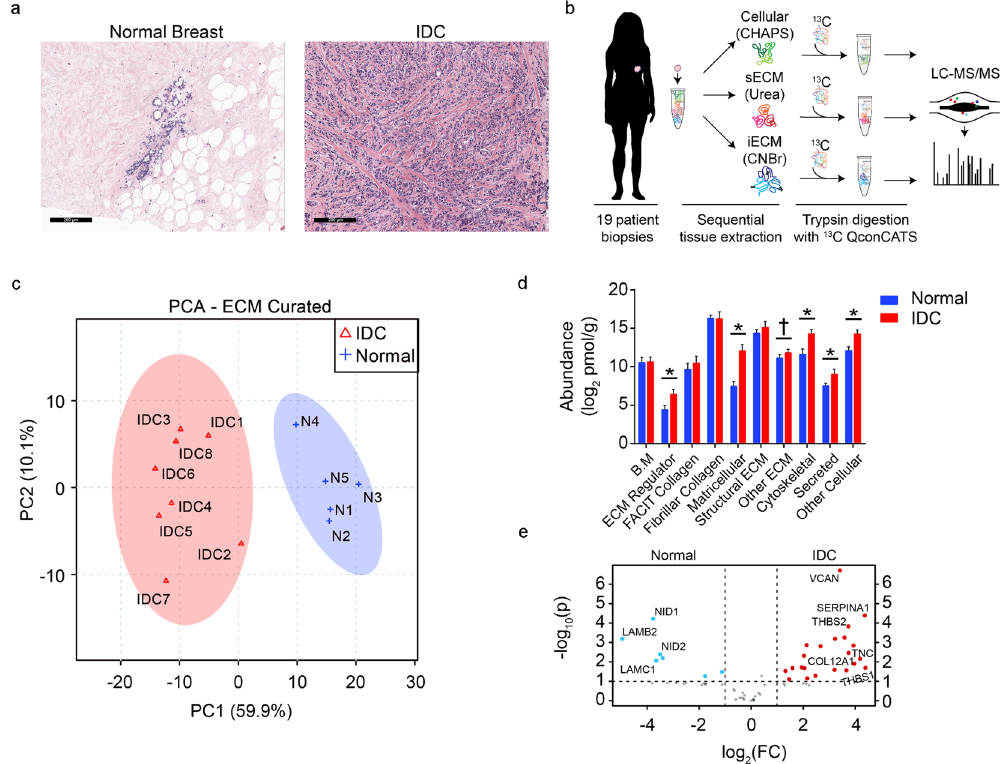
Figure 1. Targeted extracellular matrix proteomics reveals compositional changes between normal breast and IDC patient samples. ( a ) Representative H&E images of normal breast and invasive ductal carcinoma (IDC) histological sections. ( b ) Cartoon depicting the workflow for processing the frozen, human, biopsy cores, highlighting the cellular (CHAPS), soluble ECM (urea, sECM), and cyanogen bromide, insoluble ECM (CnBr, iECM) fractions from each sample before LC-MS/MS analysis. (female silhouette obtained from https://www. clipartqueen.com) ( c ) Principle Component Analysis of the quantitative ECM profile between normal breast (n = 5) and IDC (n = 8) conditions. ( d ) Bar graph representing the quantitative ECM results between normal breast and IDC samples, grouped by gene ontology, functional classifications. Error bars represent standard deviation to the mean. * p < 0.01, † p = 0.06, WRS. ( e ) Volcano plot comparing the fold change of ECM proteins between IDC and normal breast. Significance threshold set to p < 0.01, Student’s